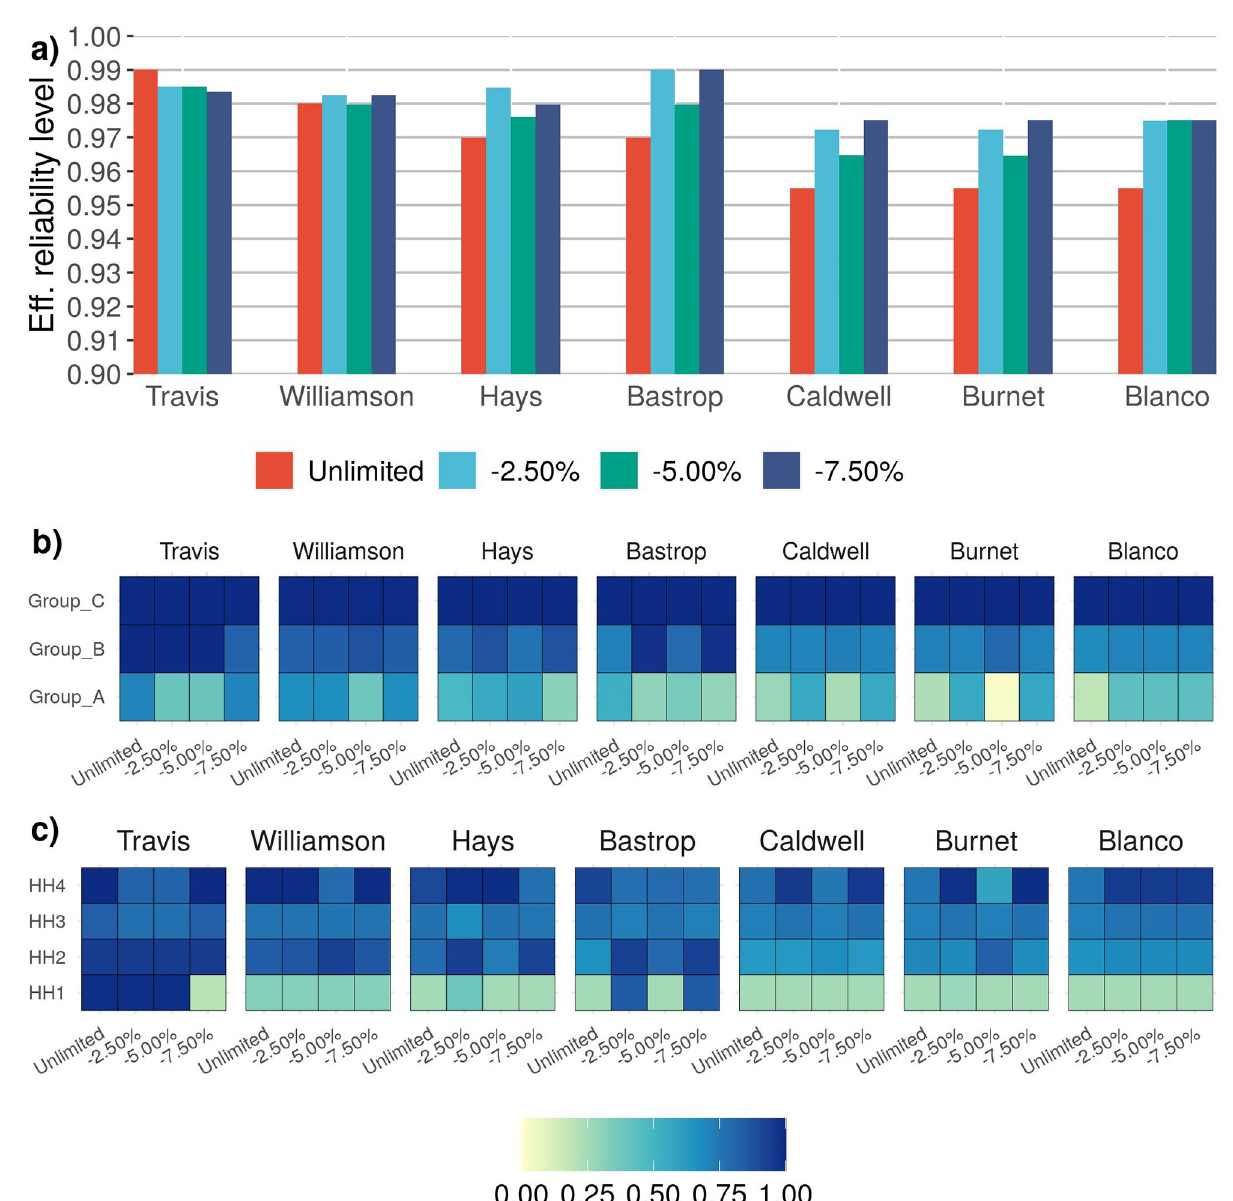
Fig 4. This figure illustrates the reliability adjustment and vaccine sharing capability prescribed by the heterogeneous model under infectivity Case 1, limited vaccine availability and High reliability level. a) The bar-plot illustrates that reliability adjustment feature of the heterogeneous model under limited vaccination. For Unlimited vaccine availability the model achieves the required High reliability but as the vaccine availability reduces the reliability levels are adjusted to achieve an optimal vaccination policy. Generally, Travis county reliability is reduced and for other counties reliability is increased. b) For each county, the heatmap illustrates proportion of population to be vaccinated within an age Group for a case of vaccine availability. It shows that for Case 1 of infectivity if the reliability is lowered and vaccines are released from a county and assigned to counties where additional reliability is achieved, generally vaccines are first released from Group A followed by Group B. And the counties receiving these additional vaccines assign them to Group C first followed by Group B. c) For each county, the heatmap illustrates proportion of population to be vaccinated within a household size for a case of vaccine availability. Across all the counties there is no clear pattern but the plot shows the vaccination policy per household size within a county.